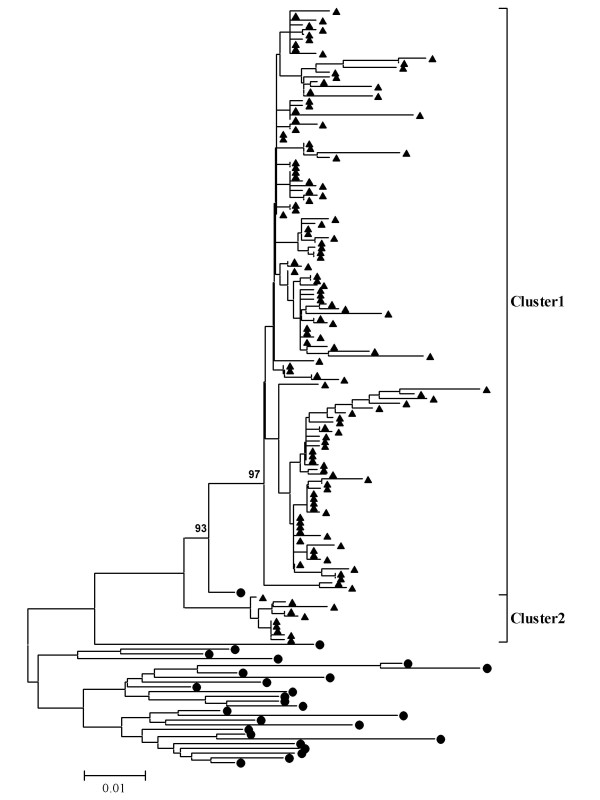
Phylogenetic tree of measles wild-type virus strains of China in 2005 (triangles) and WHO reference MV strains (dots) based on the 456 nucleotide sequences coding for the COOH-terminus of the nucleoprotein, by using MEGA4 software and the neighbor-joining method (500 bootstraps). Genetic distances are represented as numbers of nucleotide differences between strains.